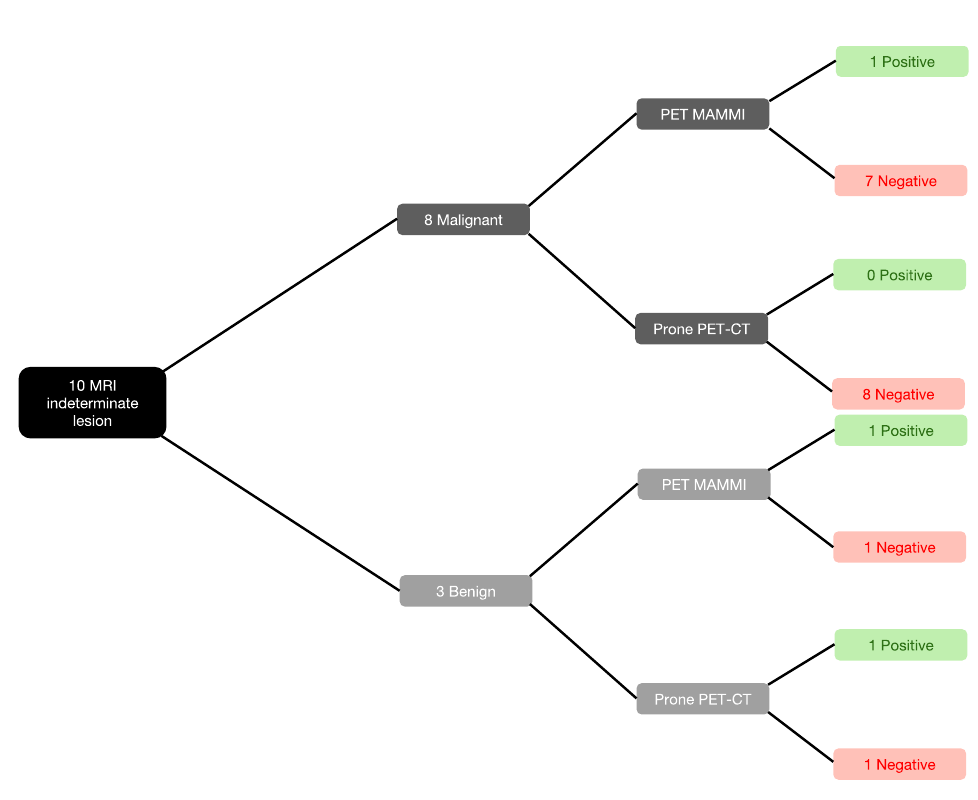
Figure 3. PET-MAMmography with Molecular Imaging (MAMMI) and prone positron emission tomography-computed tomography (PET-CT) performance against malignant and benign biopsy-proven